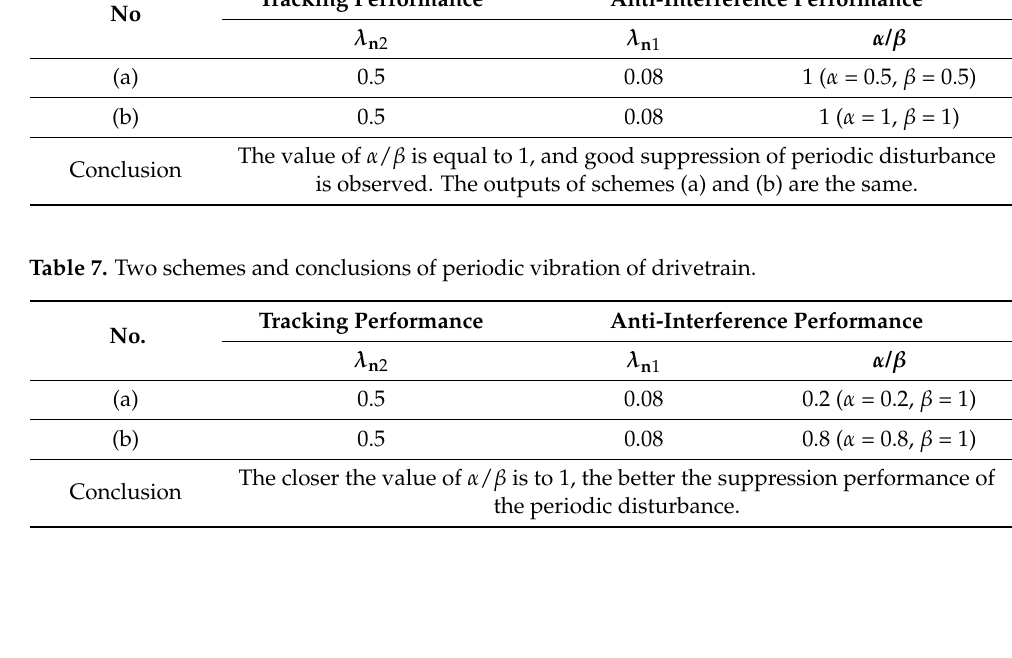
Table 6. Two schemes and conclusions of periodic perturbation. No